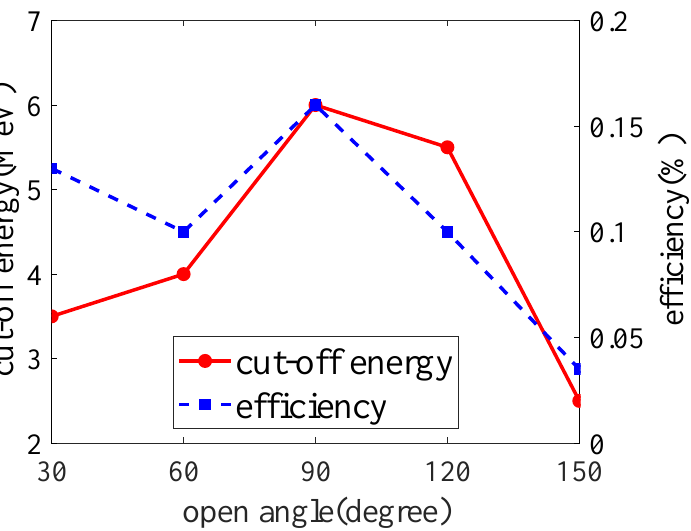
Figure 6. (Color online). Cut-off energy of photons and laser-to-photon energy conversion efficiency for five different open angles (30 ◦ , 60 ◦ , 90 ◦ , 120 ◦ , 150 ◦